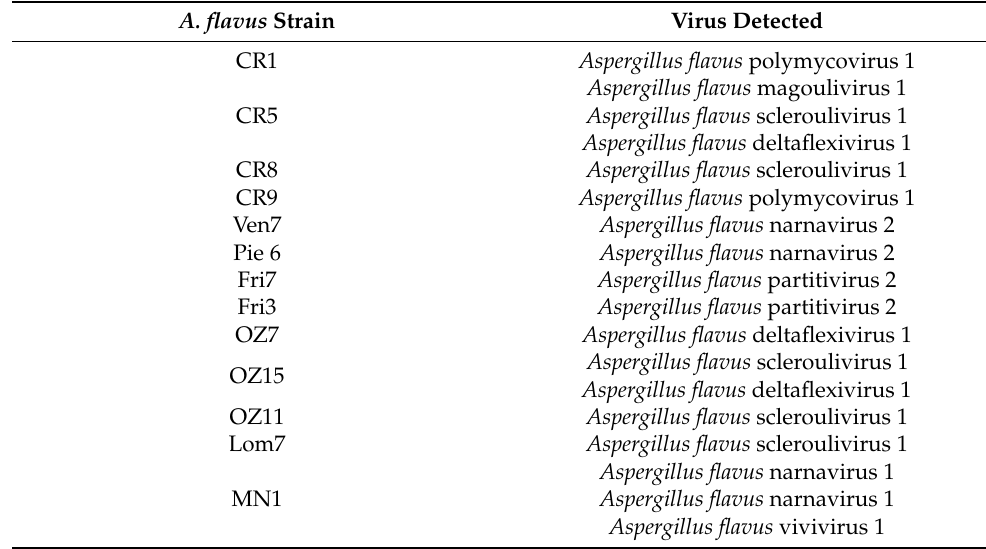
Table 2. Complete list of virus-infected A. flavus isolates with the hosted